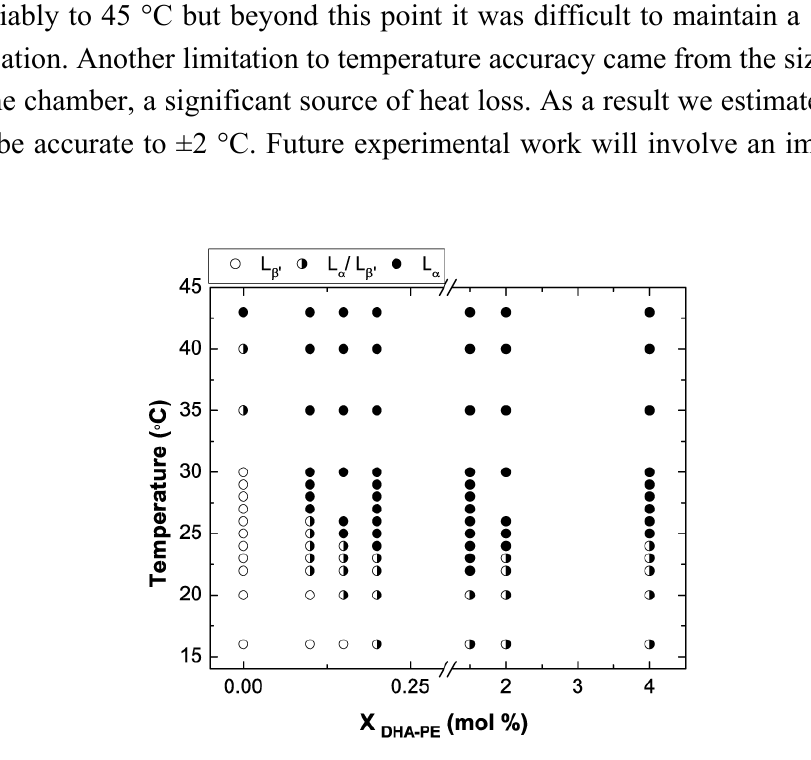
Figure 3. Binary phase diagram of DPPC/DHA-PE at low DHA-PE concentrations as determined by